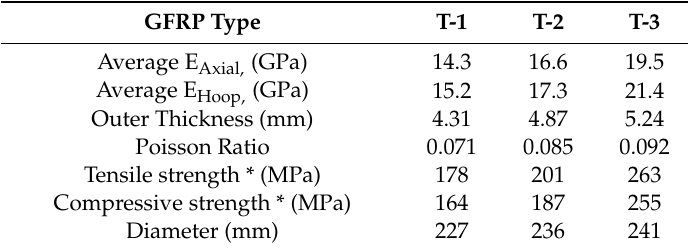
Table 2. Tested Specifications for GFRP